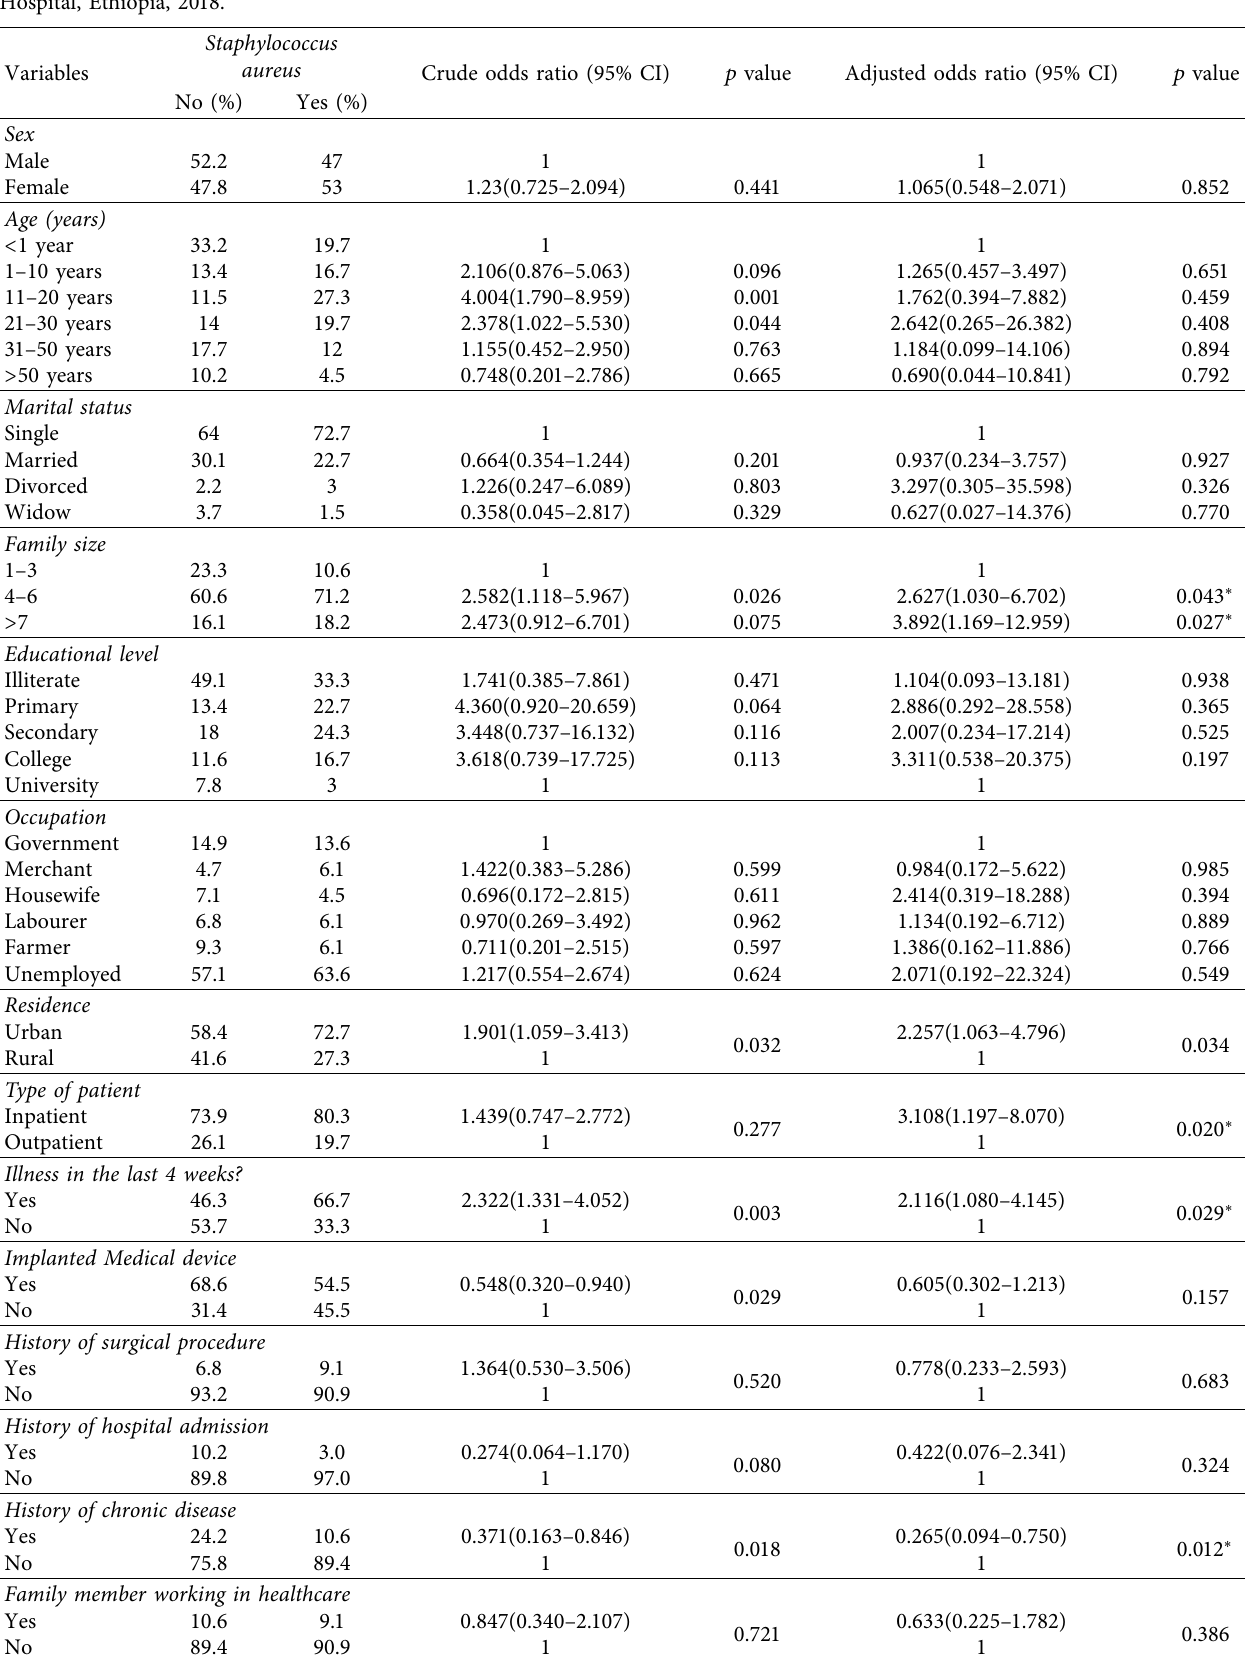
Table 3: Bivariate and multivariate analysis of S. aureus isolated from patients attending University of Gondar Comprehensive Specialized Hospital, Ethiopia,